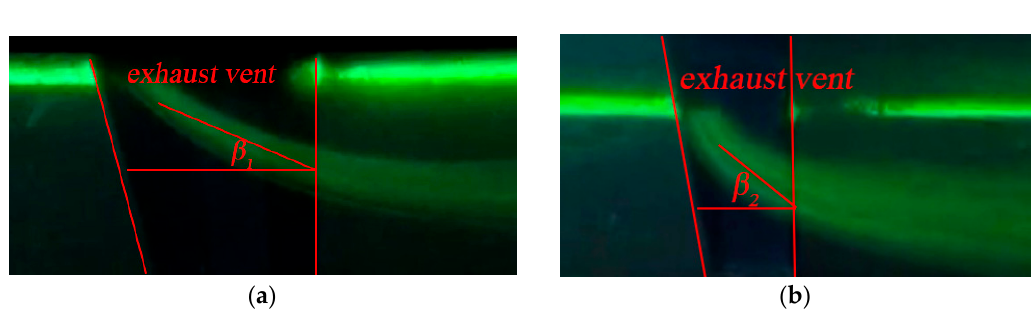
Figure 14. Inclined angle β under different extraction vent lengths ( a ) 0.1 m, ( b ) 0.05 m. Substituting Equation (17) into Equation